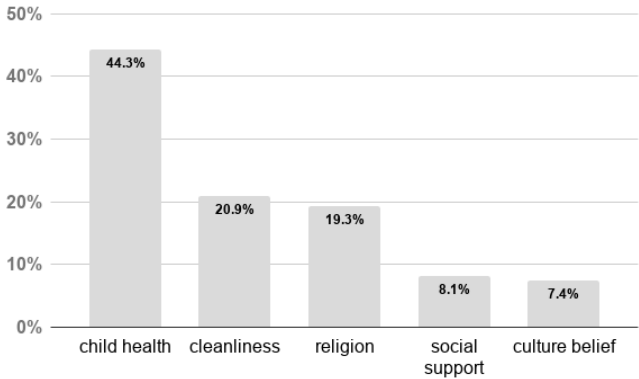
Figure 1. Reasons behind the adoption of breastfeeding among mothers attending the Primary Healthcare Care Cooperation (PHCC).